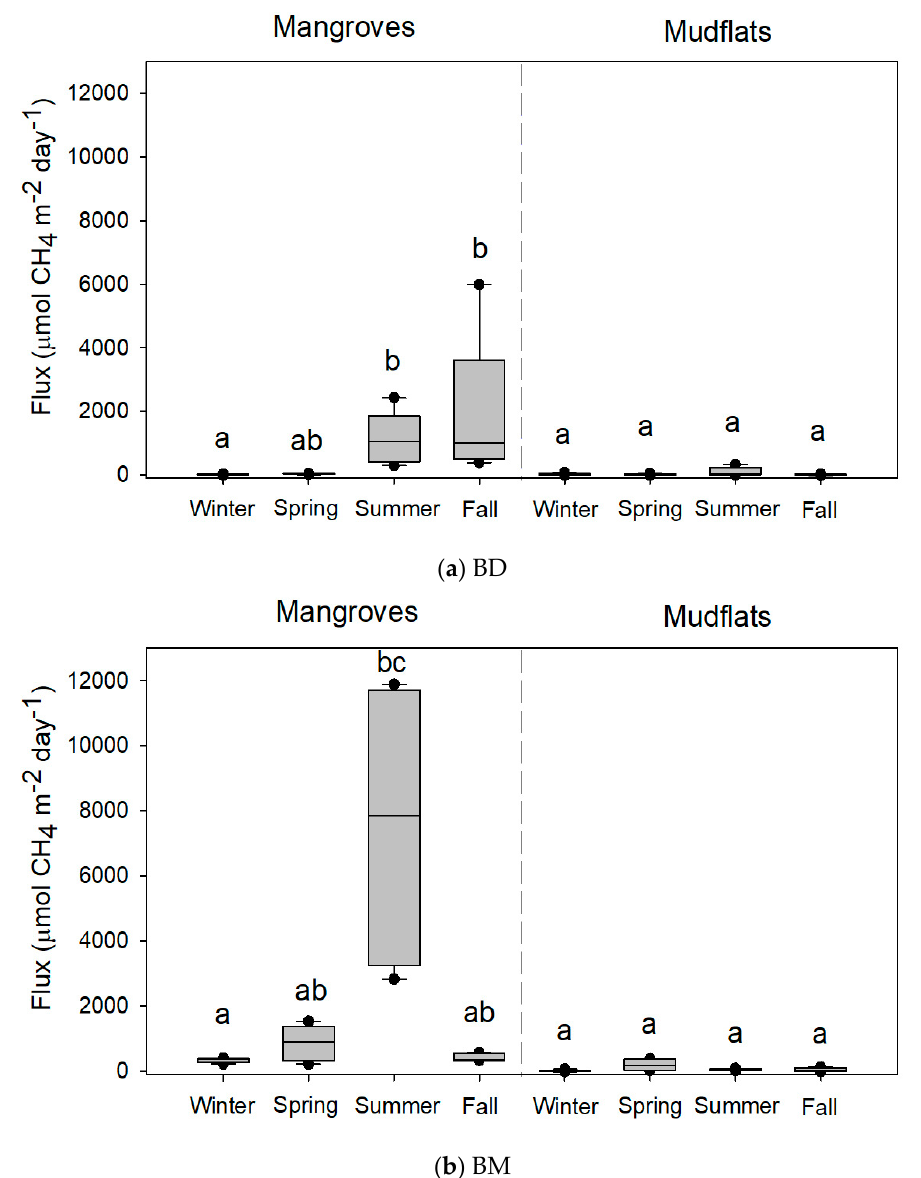
Figure 3. Methane fluxes ( n = 5 except at BM, where n = 4 in the summer of mangroves and n = 3 in the spring of mudflats) from the soils of mangroves of Avicennia marina and adjoining mudflats at ( a ) Budai (BD) and ( b ) Beimen (BM). Different letters indicate significant seasonal differences with the Kruskal-Wallis test and Tukey’s honestly significant difference (HSD) test and the Bonferroni correction for the significance level in mangroves and mudflats, respectively.